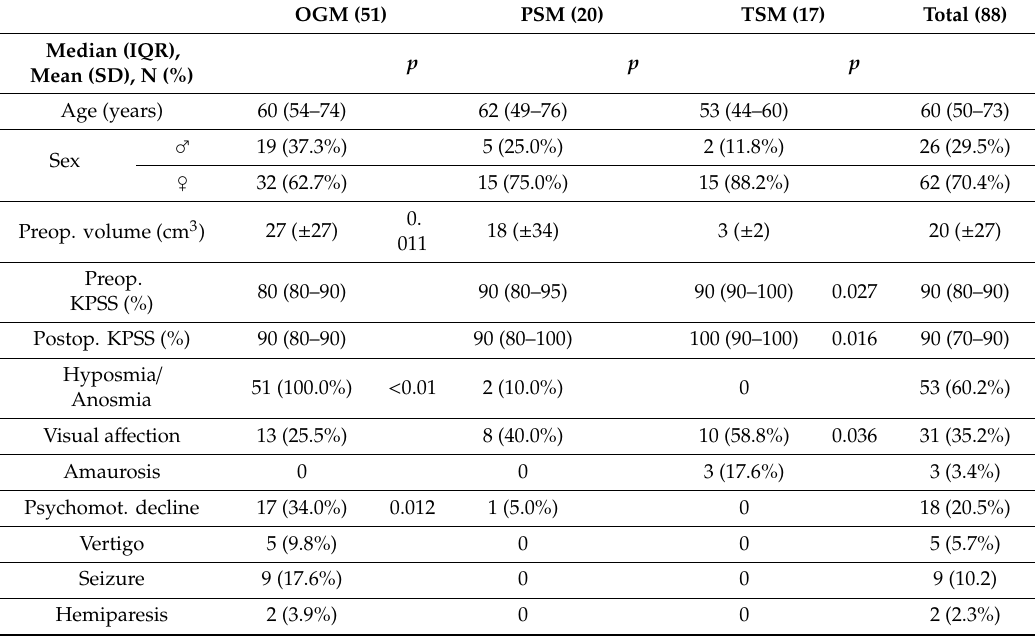
Table 1. Demographics and preoperative